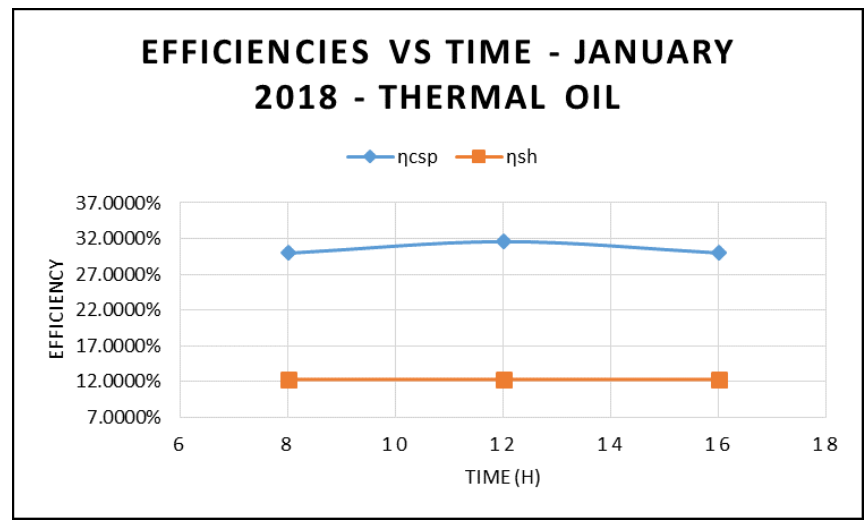
Figure 6. E ffi ciency of CSP collector and hybrid system at di ff erent angle of incidence and thermal oil Figure 6. Efficiency of CSP collector and hybrid system at different angle of incidence and thermal oil as base fluid. as base fluid.